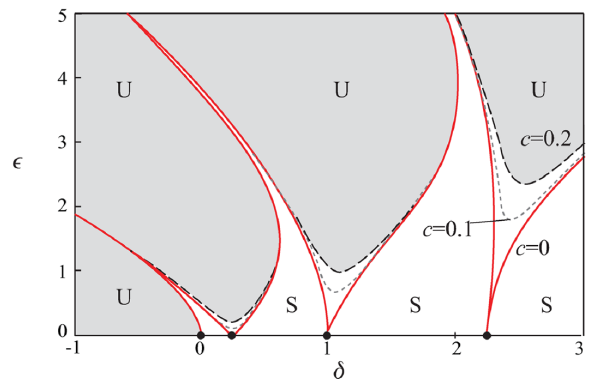
Fig. 1. Instability chart of Mathieu’s equation in Eq. (1), adopted from